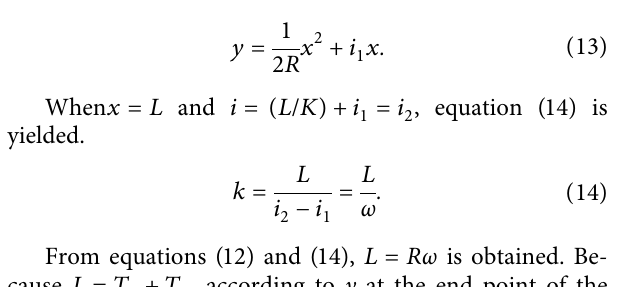
Figure 4: Schematic diagram of vertical curve